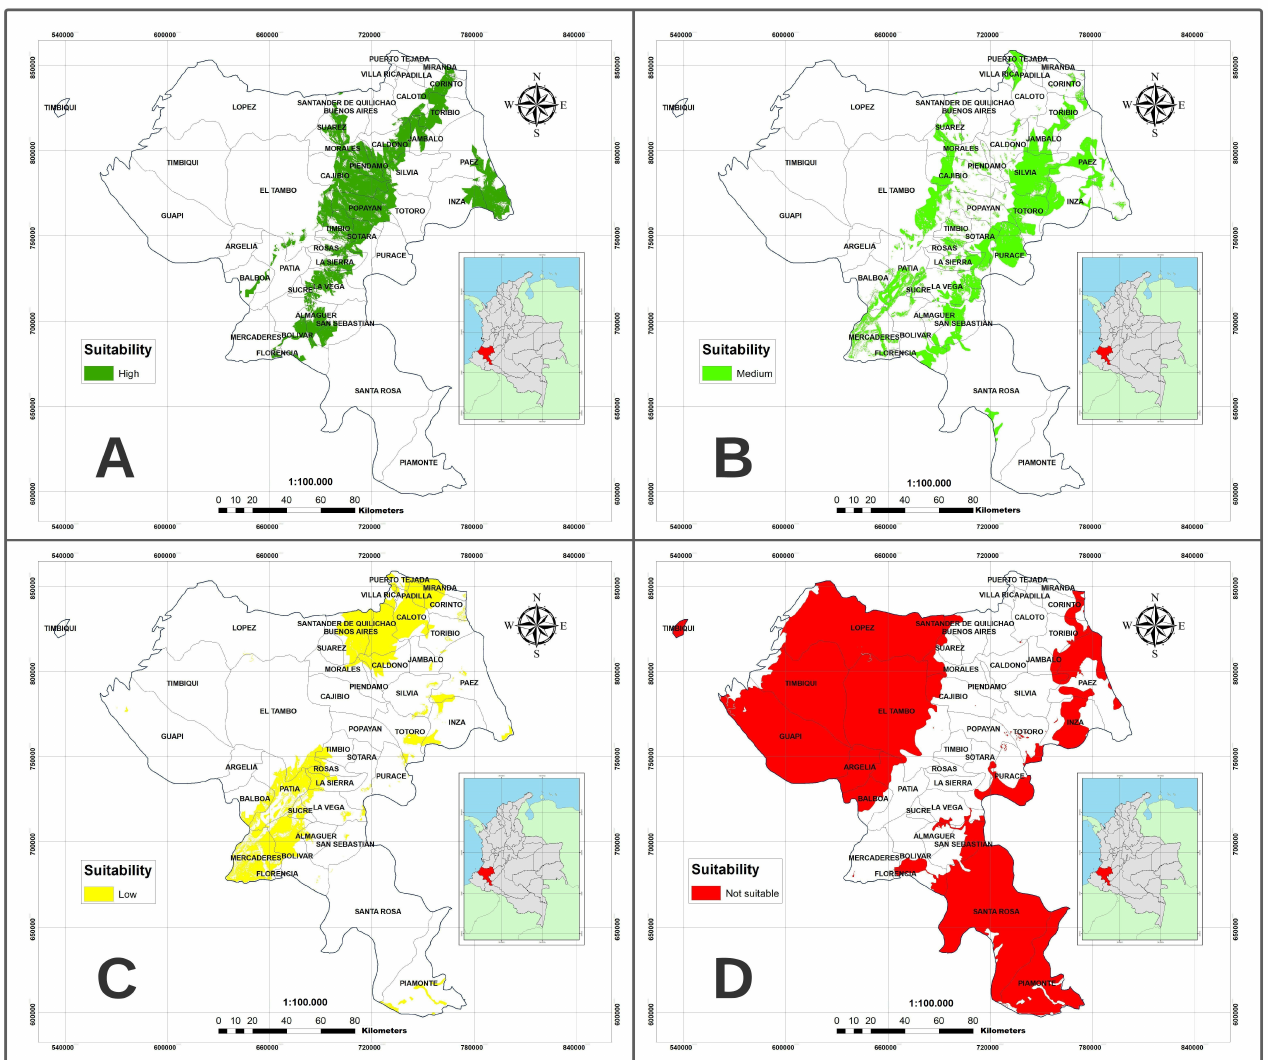
Figure 4. Partial maps of Hass avocado cultivation zones in Cauca department: high ( A ), medium ( B ), low aptitude ( C ) and unsuitability ( D ) for cultivation in administrative